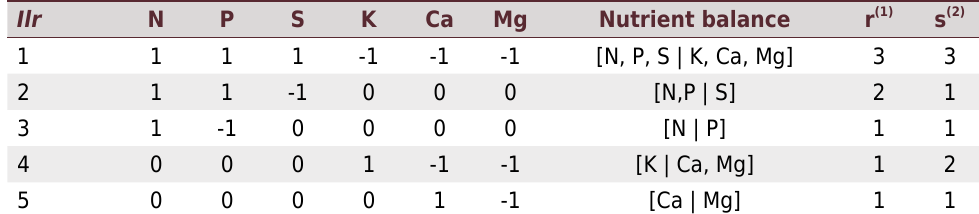
Table 2. Sequential binary partition of leaf nutrient